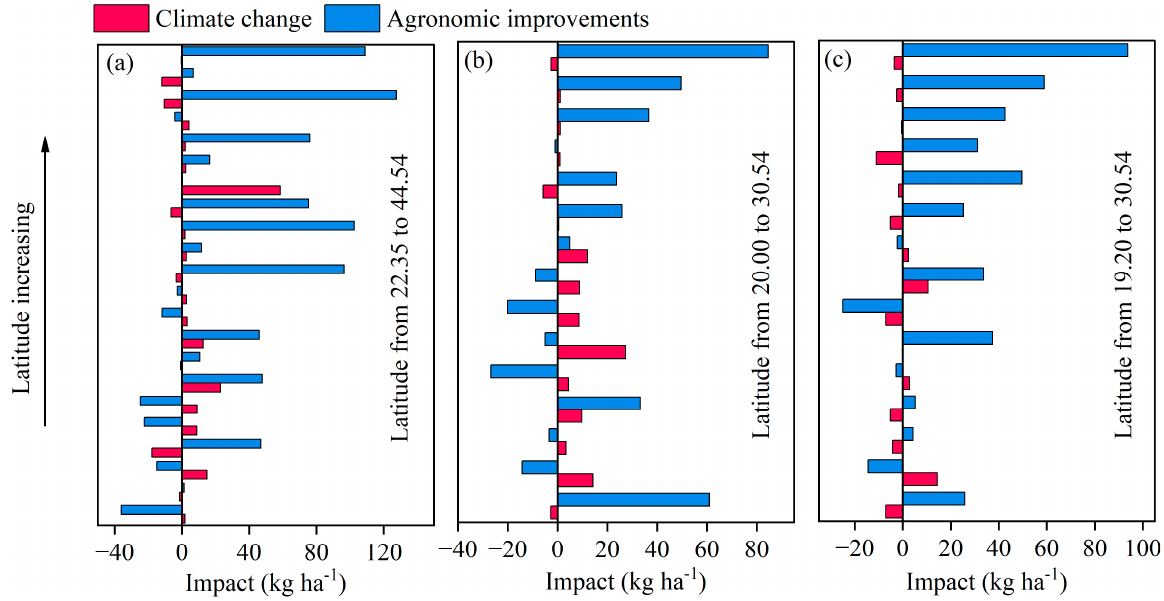
Figure 4. Effects of climate change and agronomic improvements on rice yield at different stations. ( a – c ) Single rice, early rice, and late rice,